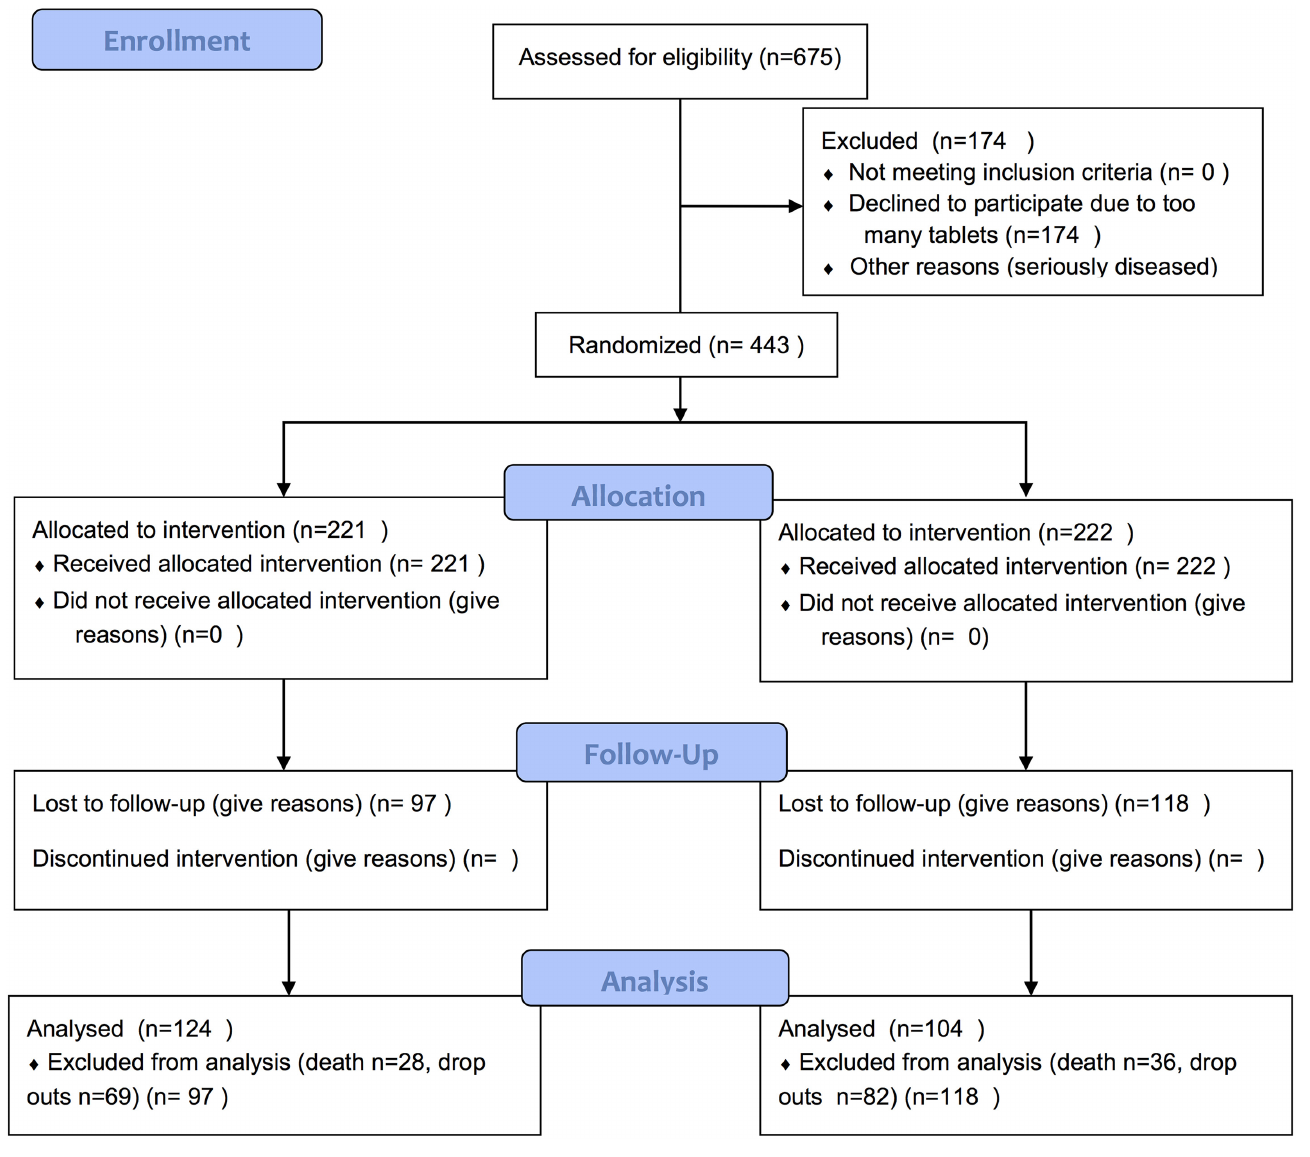
Fig 1. CONSORT flow chart of the